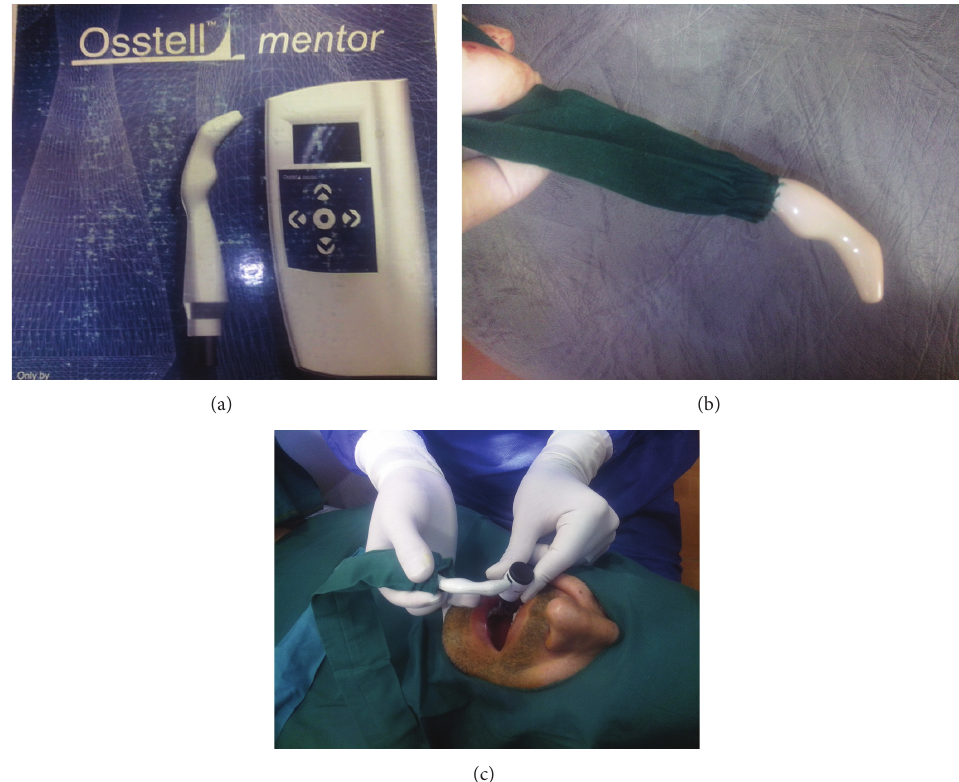
Figure 1: (a) Osstell mentor device. (b) Osstell mentor probe. (c) Osstell mentor device is in contact with the fixture immediately after placement to measure the baseline stability value of the implant. The same procedure was done once a week until the 5th week after surgery, and then was done once in the 7th and once in the 11th